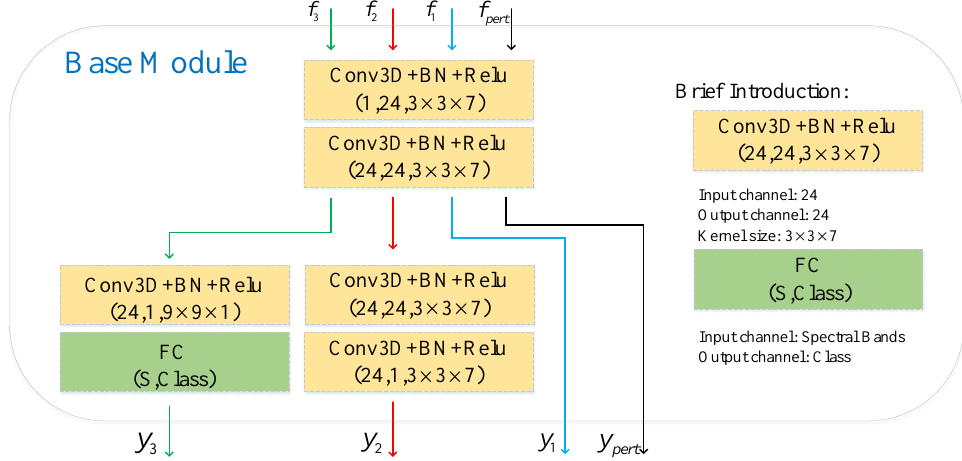
Figure 3. The details structure of the base